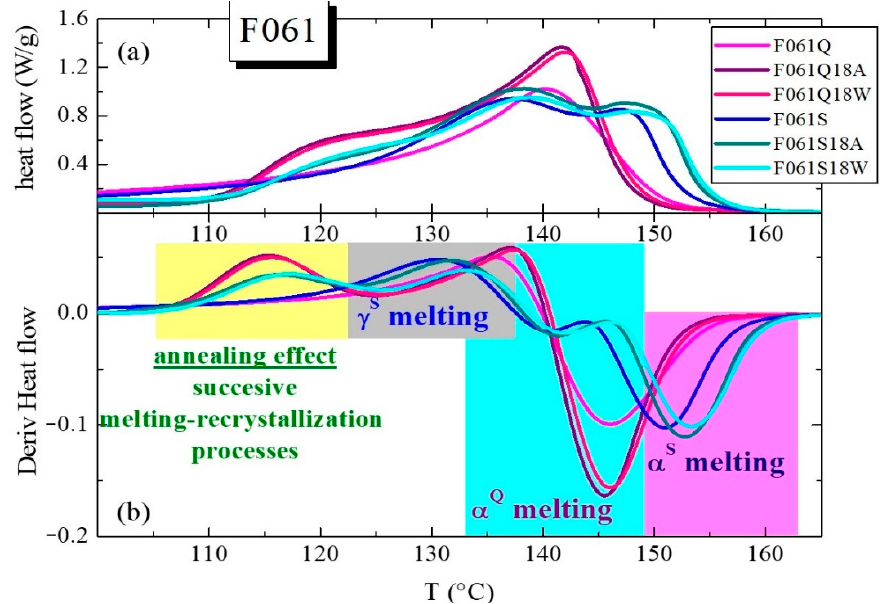
Figure 5. ( a ) DSC curves obtained for P061-based materials: Q and S (F061Q and F061S) films and their emulated thermal treatments in warm dry air (F061Q18A and F061S18A) or immersed in water (F061Q18W and F061S18W). ( b ) Derivatives corresponding to the different DSC curves. The presence of inorganic components could contribute to increased heterogeneity.